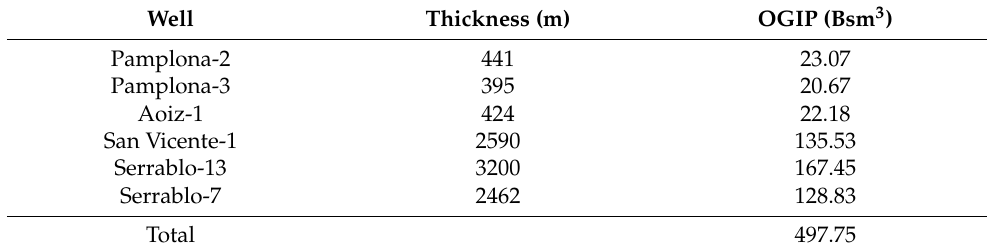
Table 3. Calculated volume of gas reserves in each well.